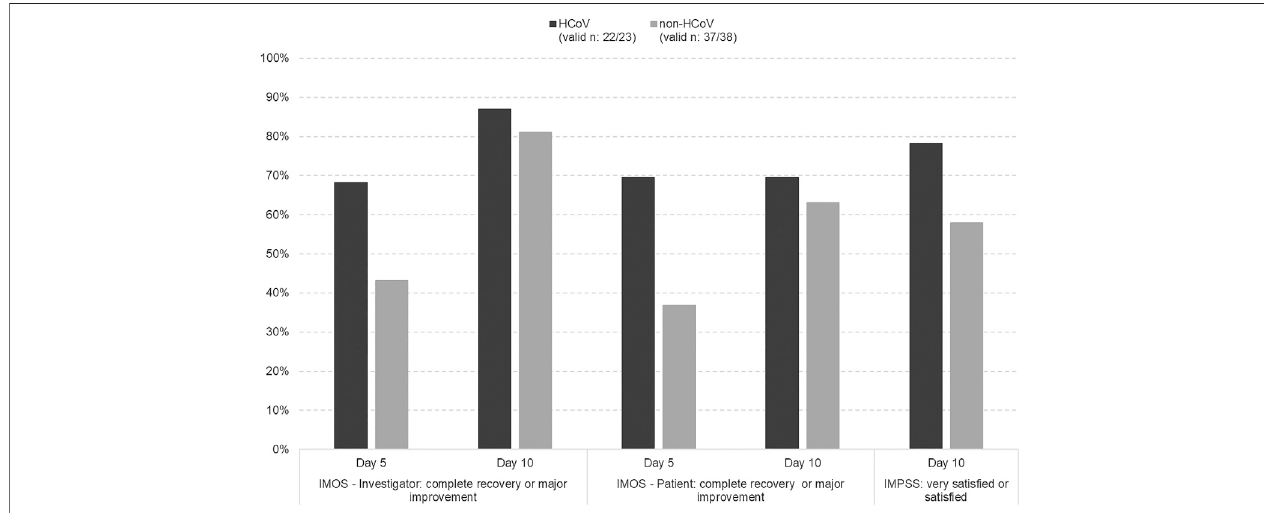
FIGURE 4 | Treatment outcome (IMOS) and satisfaction with treatment (IMPSS) – % of patients with a favourable response in the HCoV and non-HCoV subsets